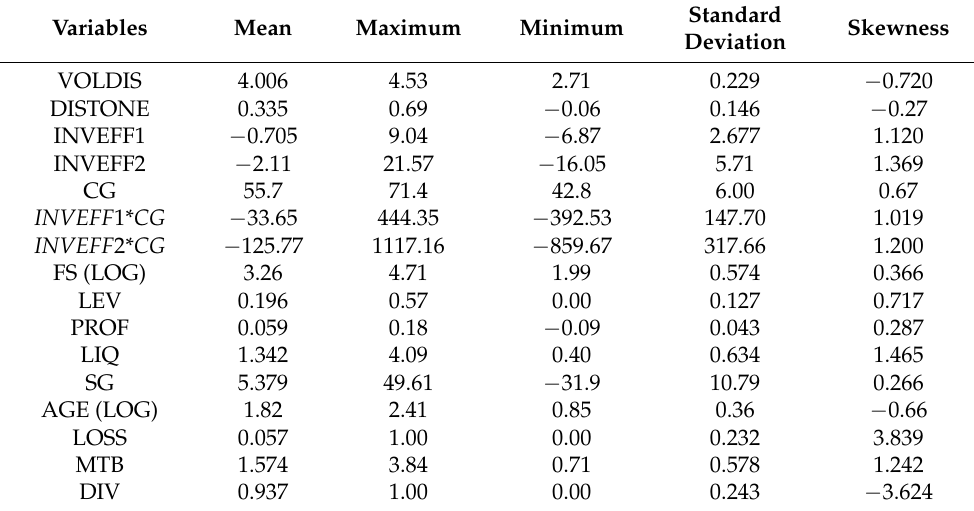
Table 2. Descriptive